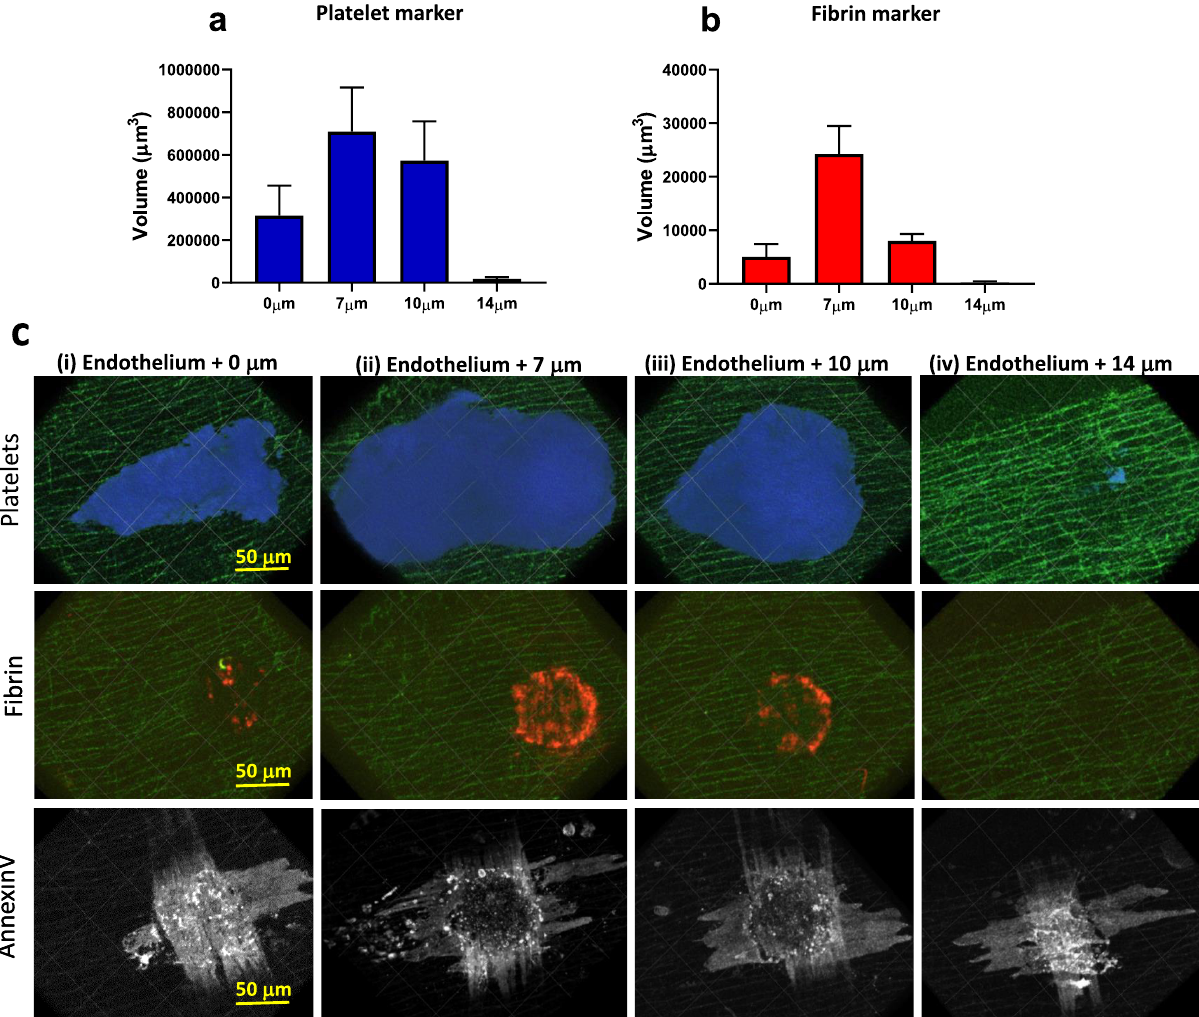
Figure 2. Optimisation of scanning-LIEI laser targeting depth. The scanning laser was targeted at the level of the endothelium (0 μm), 7 μm luminally of the endothelium (7 μm), 10 μm luminally of the endothelium (10 μm), or 14 μm luminally of the endothelium (14 μm). ( a ) Quantification of platelet volume 5 min after injury. ( b ) Quantification of fibrin volume 5 min after injury (n = 3–11 injuries from 3–5 mice). ( c ) Representative XY surface 3D reconstructions of thrombi (platelets blue, fibrin red), annexin V (white), and autofluorescent elastin layer (green). Blood flow is from right to left. Top row: platelet accumulation 5 min after injury. Middle row: Fibrin formation 5 min after injury. Bottom row: Annexin V binding > 30 min after injury. The laser was targeted (1) at the endothelium, (2) 7 μm luminally of the endothelium, (3) 10 μm luminally of the endothelium, or (4) 14 μm luminally of the endothelium. Note the strong annexin V binding to transverse smooth muscle cells and minimum fibrin formation after endothelium + 0 μm targeting. Also note the annexin V-positive endothelium without stable thrombus formation in the + 14 μm injury indicating that endothelial damage/activation alone is not sufficient for stable thrombus formation in this model. Scale bar and grid size 50